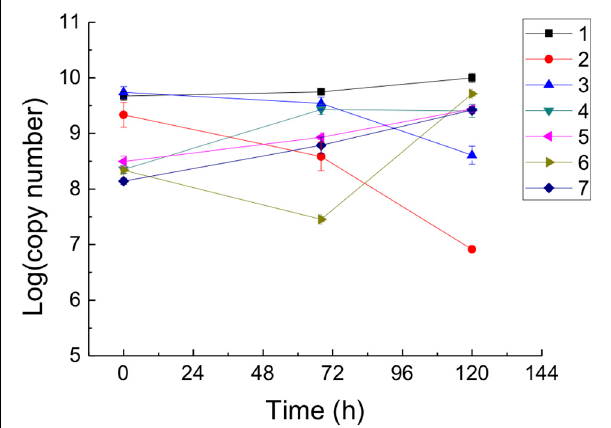
FIGURE 2 | Biomass quantifying of strain YN101 T , B. sediminis FA350 T and prey Algoriphagus marinus am2 T mono-cultured and co-cultured for different time (0, 68, and 120 h) using fluorogenic quantitative PCR. Horizontal axis represented incubation time, and vertical axis represented the logarithm of gene copy number. 1, A. marinus am2 T (RuBisCO); 2, P. caeni YN101 T and A. marinus am2 T (RuBisCO); 3, B. sediminis FA350 T and A. marinus am2 T